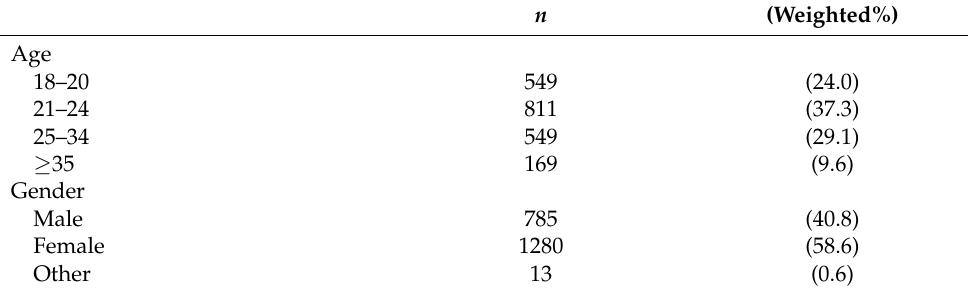
Table 1. Demographic and tobacco use characteristics of participants ( n =